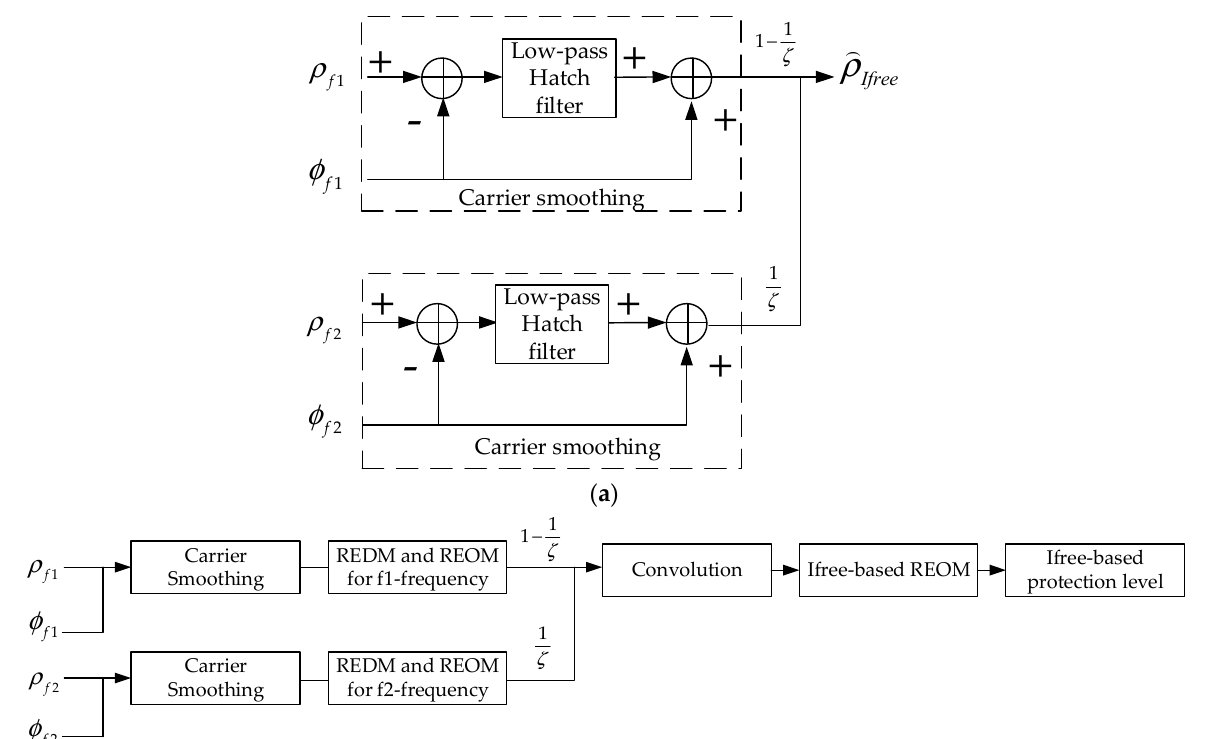
Figure 2. An equivalent diagram of the Ifree filtering process ( a ) and the overall corresponding overbounding process for an Ifree-based GBAS ( b ). The dotted-line block in ( a ) is the carrier smoothing module in ( b ).